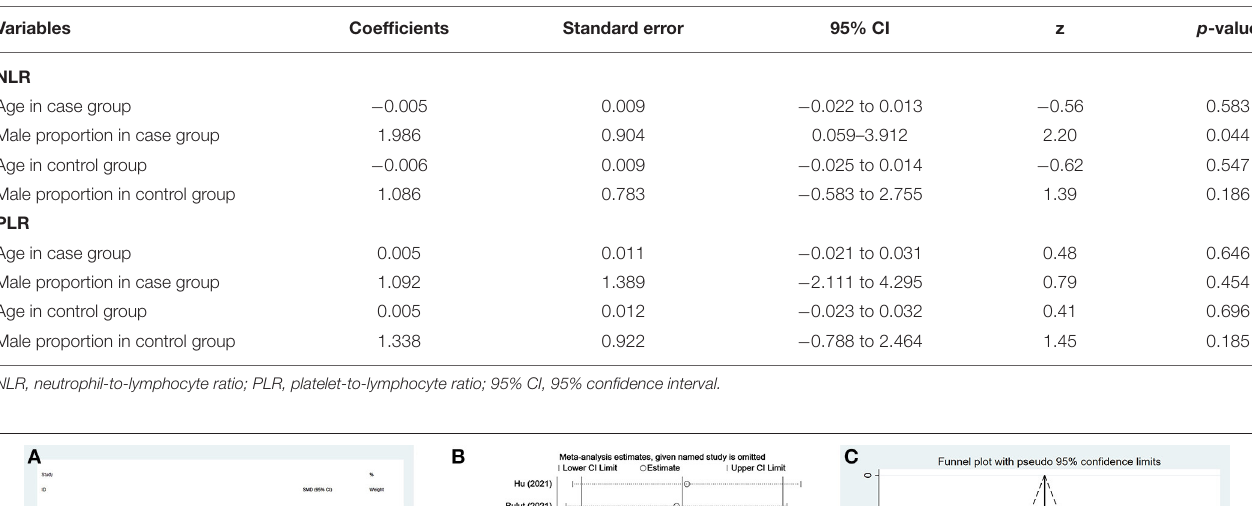
TABLE 4 | Results of meta-regression analysis.